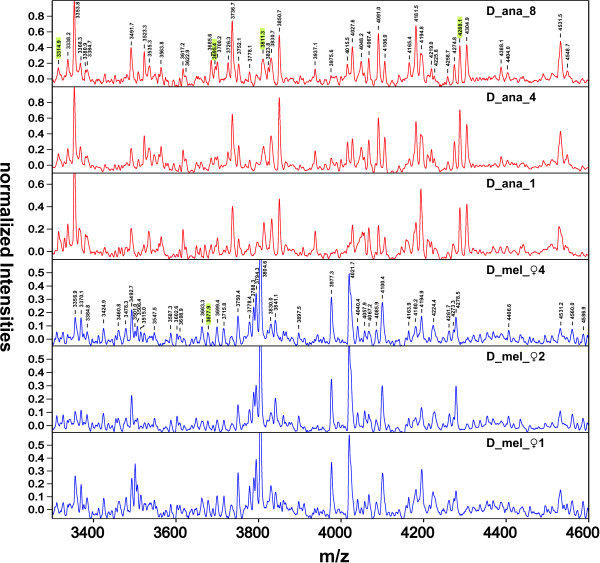
Comparison of six MALDI-MS spectra, 3.3 to 4.6 kDa. The upper three spectra (red) were obtained with three different flies from D. ananassae, whereas the lower three (blue) were from different (female) D. melanogaster specimens. Peaks detected by FlexAnalysis are indicated for two representative spectra. Peaks highlighted in green were used for stringent species discrimination in the generation of the final dendrogram (Fig. 4).